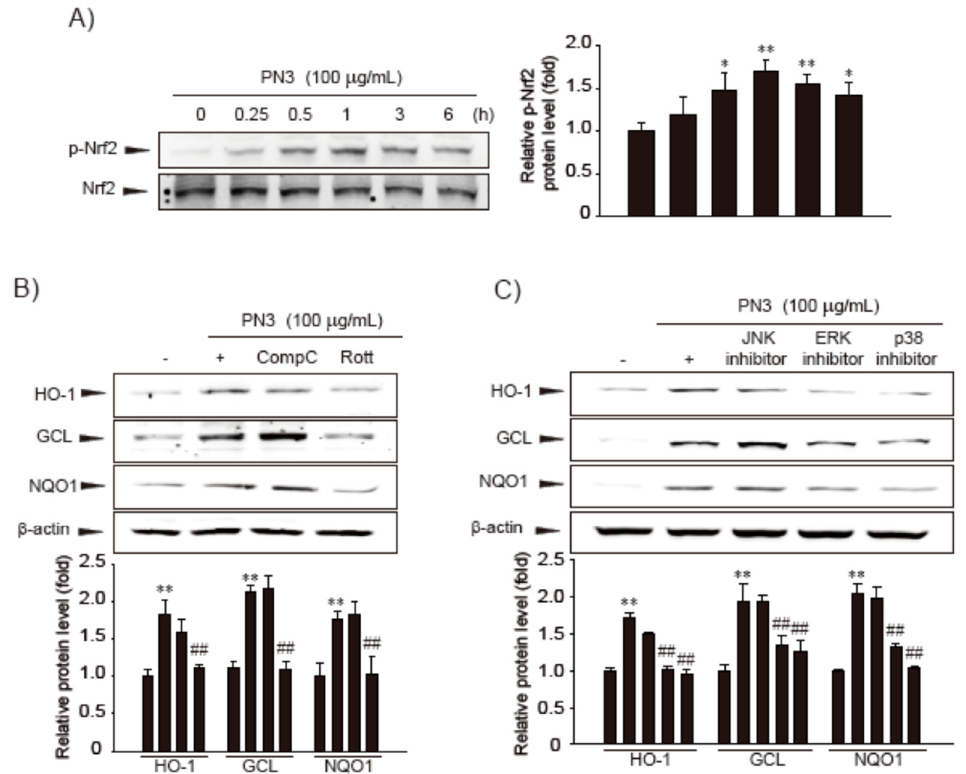
Figure 3. The effect of PN3 on Nrf2 activation. ( A ) Immunoblot analysis for phosphorylation of Nrf2 in HepG2 cells treated with PN3. Levels of Nrf2 phosphorylation were determined in the cell lysates